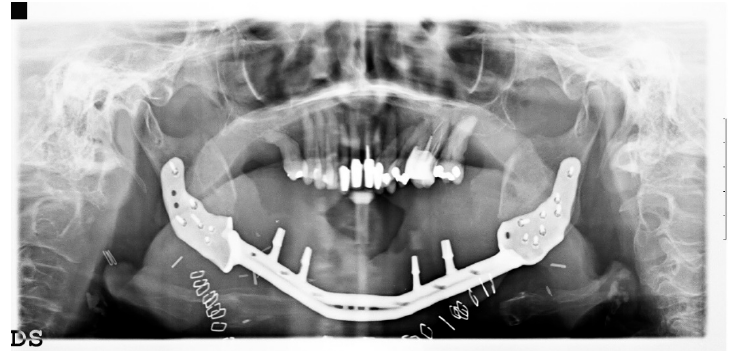
Figure 14. Intraoral view of rehabilitation.